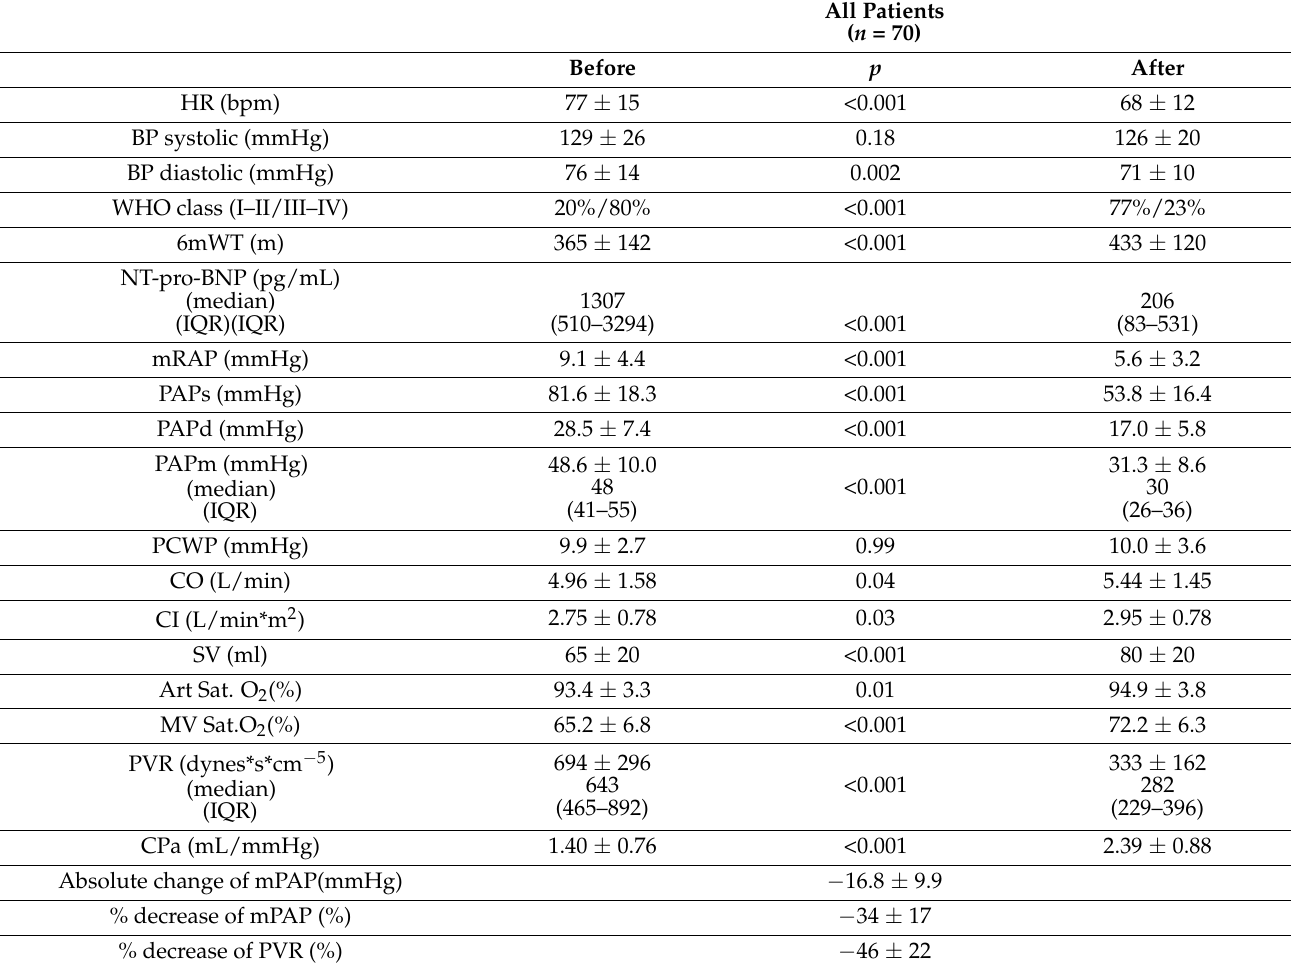
Table 2. Clinical and hemodynamic effect of BPA in all patients.